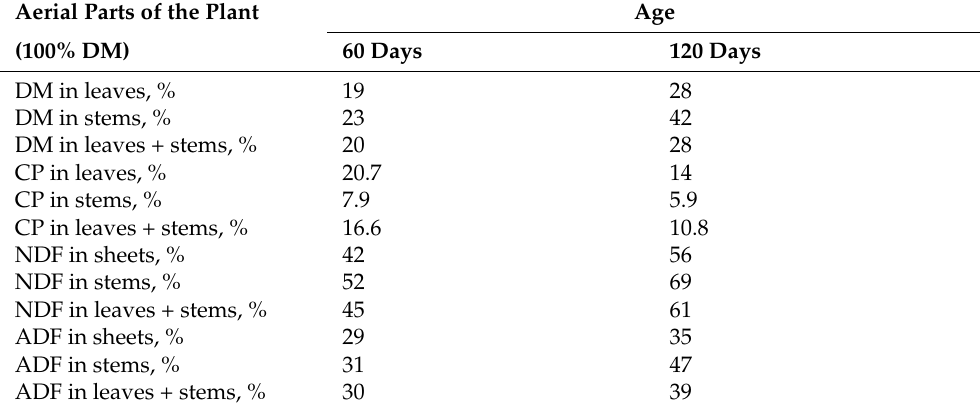
Table 3. Effect of regrowth cutting age on DM yield and chemical composition (100% DM) of forage. Leaves + Petioles +